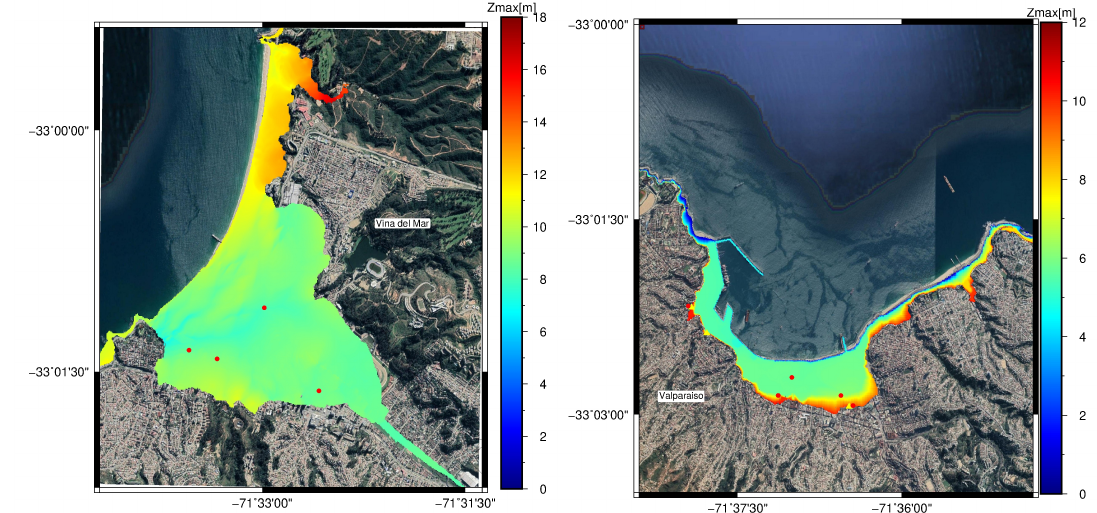
Figure 5. Resulting maximum wave heights in Viña del Mar (left panel) and along the coastal city of Valparaíso (right panel). The seismic source used as the initial condition was based on [1]. Red points stand for the locations of schools shown in Figure